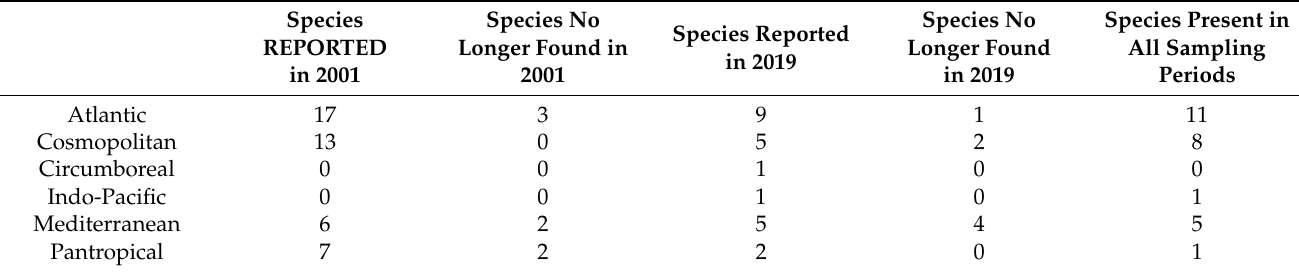
Table 5. Variations in the number of Atlantic, Cosmopolitan, Circumboreal, Indo-Pacific, Mediterranean, and Pantropical species observed from the 1970s to 2019 in the coralligenous flora of the MPA.